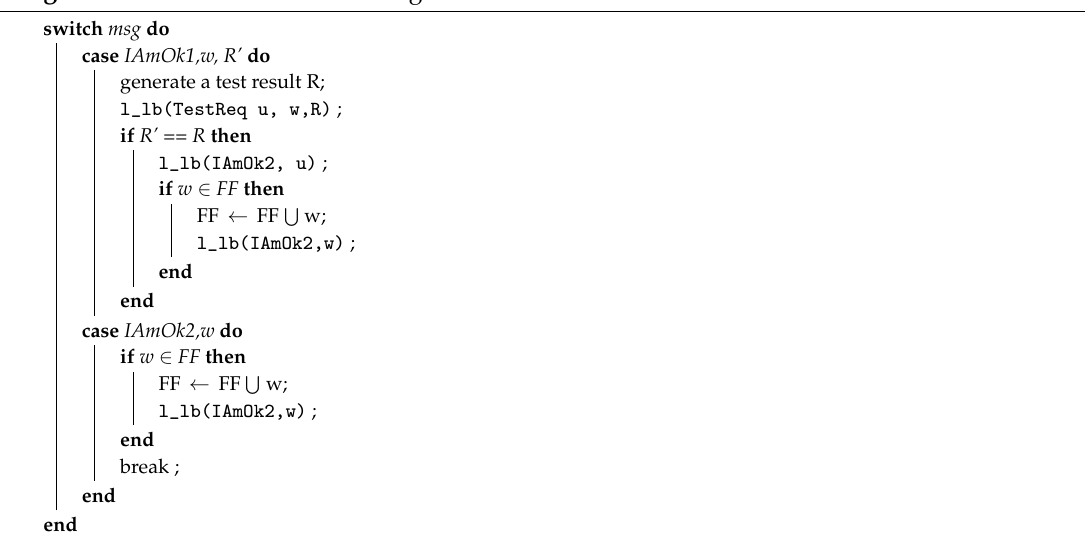
Algorithm 4: Procedure: